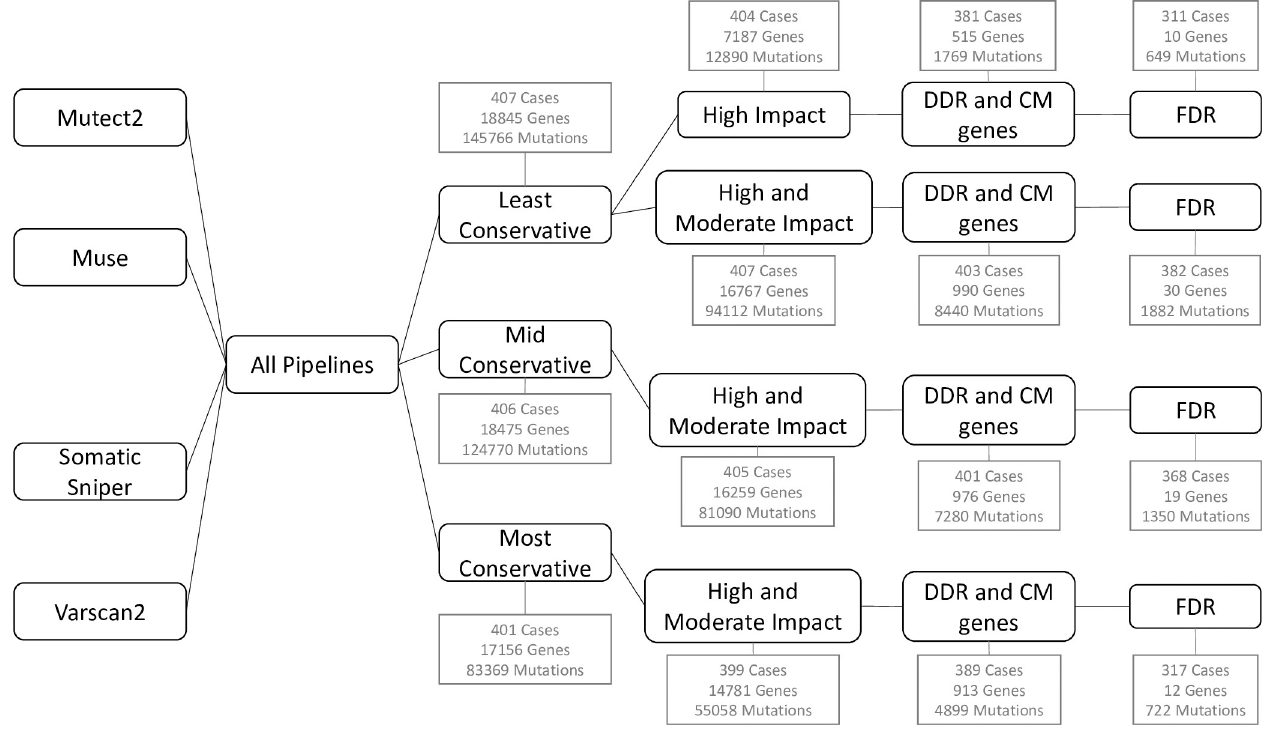
Fig 1. Pipeline for dataset generation. Pathways show the data selection and trimming process through each of the Lest Conservative, Mid Conservative and Most Conservative approaches. The number of cases, genes and mutations (mut) in the data at each step of the refinement process are presented in square